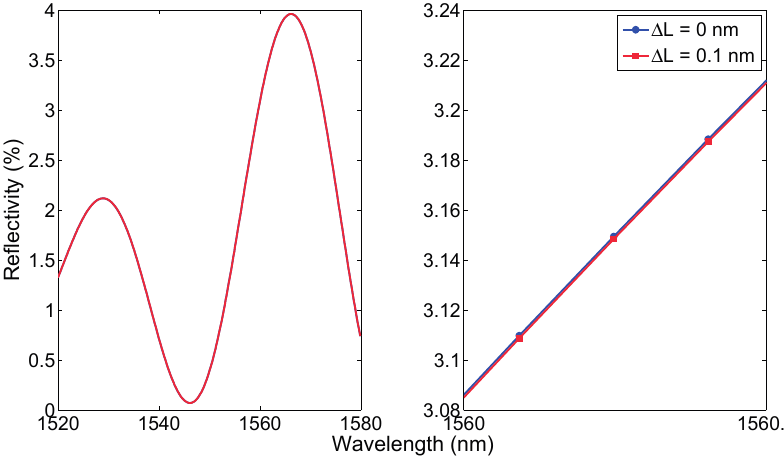
Figure 2. Benchmark for simulation of an FPI sensor. ( Left ) original spectrum, in reference condition ( Δ L = 0 nm), and with a Fabry-Perot cavity expansion Δ L = 0.1 nm; ( Right ) zoom on a 0.5 nm spectral